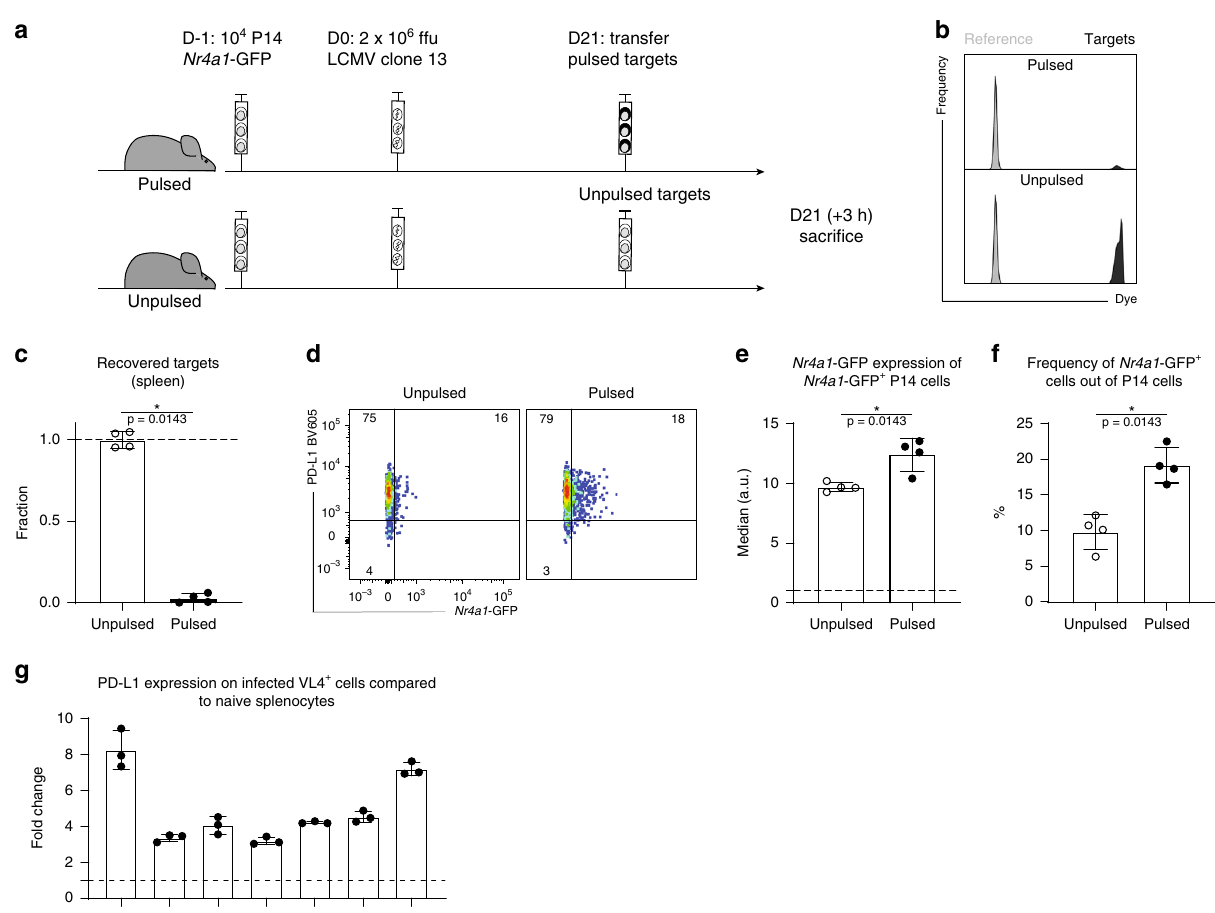
Fig. 7 In vivo cytotoxicity of exhausted CD8 + T cells 3 weeks into chronic LCMV infection. a CD45.1 + P14- Nr4a1 -GFP cells were adoptively transferred into naive CD45.1 + mice 1 day prior to high-dose LCMV clone 13 infection. Twenty-one days post infection, the hosts received gp 33 – 41 -pulsed or unpulsed labeled targets together with a reference population. Three hours later the mice were sacri fi ced. b Representative plots of transferred targets isolated from the spleen. c Fraction of recovered targets (calculated based on the reference population) in spleens isolated from unpulsed or pulsed groups is shown. d Representative fl ow cytometry plots showing ex vivo Nr4a1 -GFP expression in P14 cells (gated on alive single CD8 + CD45.1 + cells) from the spleens of mice, which received unpulsed or pulsed targets. Medians of GFP (gated on alive single CD8 + CD45.1 + GFP + cells) ( e )) and frequency ( f ) of GFP + cells (out of P14 cells) are shown. g Fold change of PD-L1 expression between infected cells (gated on alive single VL4 + cells) isolated from different tissues 3 weeks into chronic LCMV infection and naive splenocytes (dotted line). Bar plots represent mean ± SD. Asterisk (*) denotes a signi fi cant p -value ≤ 0.05 (Mann – Whitney one-tailed-test). One of three experiments is shown ( n = 4 ( c – f ), 3 ( g ) mice). Each dot represents an individual mouse. See also Supplementary Fig. 6. Source data are provided as a Source Data was performed in GraphPad Prism 8.2.0 (La Jolla, California, USA). Gating strategy is shown in Supplementary Fig. 7. In order to facilitate comparison of GFP medians between different experimental time points, GFP values were normalized by the values of a reference population (GFP median of non transgenic CD8 + cells). GFP values shown in Figs. 2c, 4c, 6d, 7e and Supplementary Figs. 1d, 5d, 6c are nor- malized and represent fold increase compared to the reference population. In vivo blocking . One dose of blocking antibodies (200µg of α -PD-L1 (clone 10 F.9G2), α -TIM-3 (clone RMT3-23), α -LAG-3 (clone C9B7W), α -CTLA-4 (clone UC10-4F10-11), α -TIGIT (clone 1B4) 49 ) were administered IV 3, 6, or 12 h prior sacri fi ce. In vivo killing assay . Splenocytes were incubated at 37 °C for 1h with or without 0.1µg/ml gp 33 – 41 in RPMI, labeled with cell proliferation dye (eFluor 450 or Cell Trace Yellow, Thermo Fisher) according to manufacturer ’ s protocols. The refer- ence population and the target population (pulsed or unpulsed) were mixed (15 × 10 6 splenocytes per population) and transferred IV into chronically infected mice. After 3h, the animals were sacri fi ced and target cell abundance was quanti fi ed by fl ow cytometry.